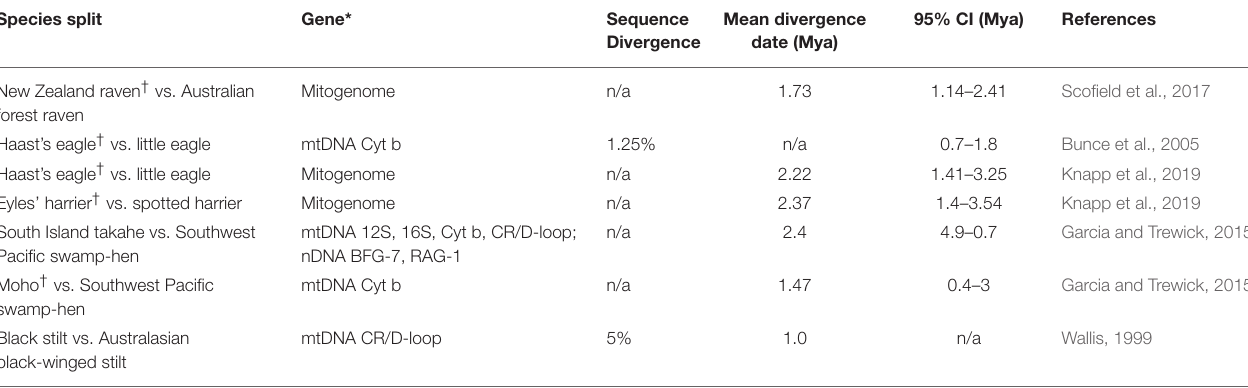
TABLE 1 | Divergence time estimates for splits between Australian and New Zealand avian species pairs. Species